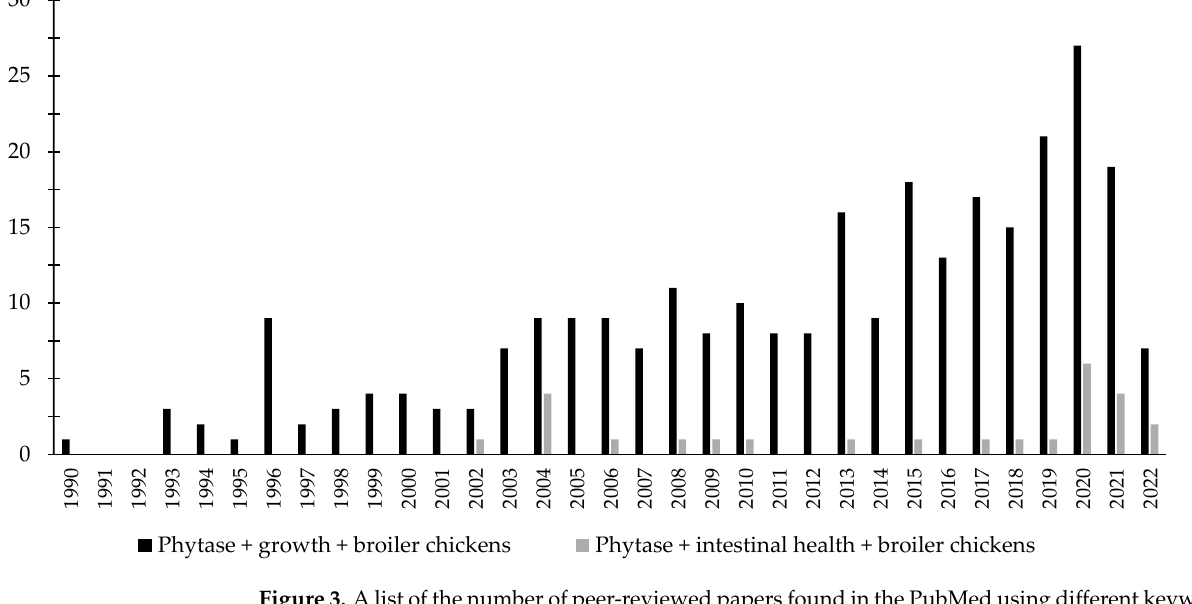
Figure 3. A list of the number of peer-reviewed papers found in the PubMed using different keywords. Black bars: phytase, growth, broiler chickens as key words; grey bars: phytase, intestinal health, broiler chickens as keywords.